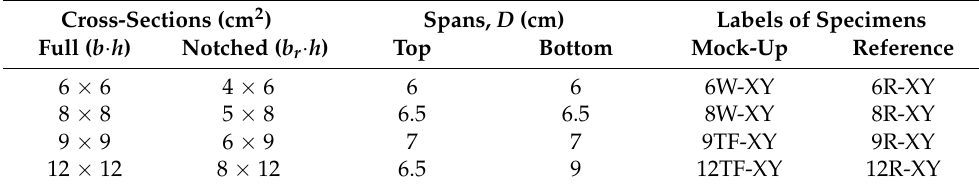
Figure 5. Setup based on the FIP test [38]: ( a ) front side of the test setup (the rear side has an equal setup with the addition of a clip gauge, as shown in the dashed line); ( b ) side view of the test setup; ( c ) tests at different loading stages.